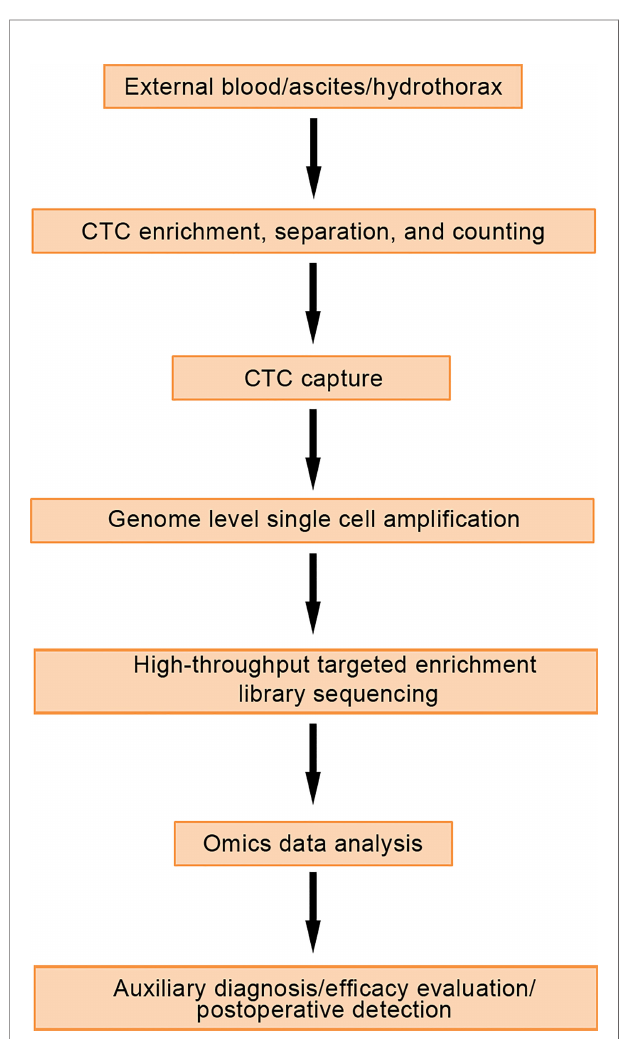
FIGURE 1 | Detection process and application of circulating tumor